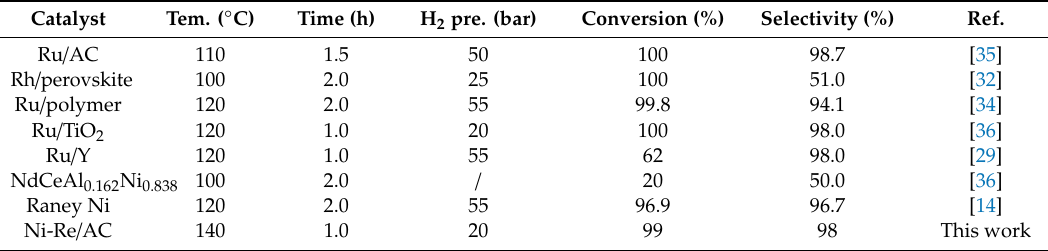
Table 3. Summary of the catalytic hydrogenation of xylose to xylitol with various catalysts. Catalyst